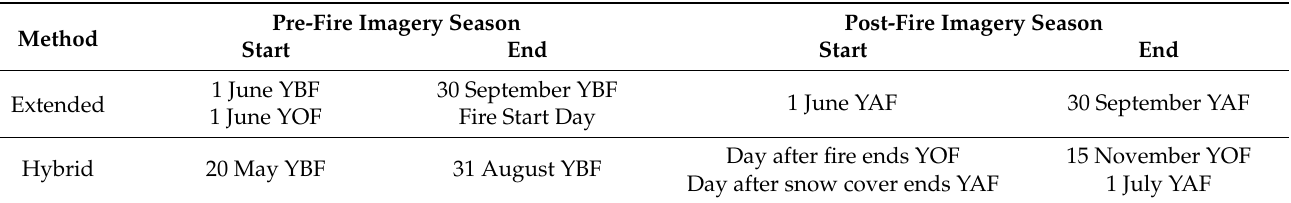
Table 3. Image season date ranges for pre- and post-fire imagery used in composite imagery methods for calculating burn severity. YBF indicates “Year Before Fire”, YOF indicates “Year of Fire”, and YAF indicates “Year After